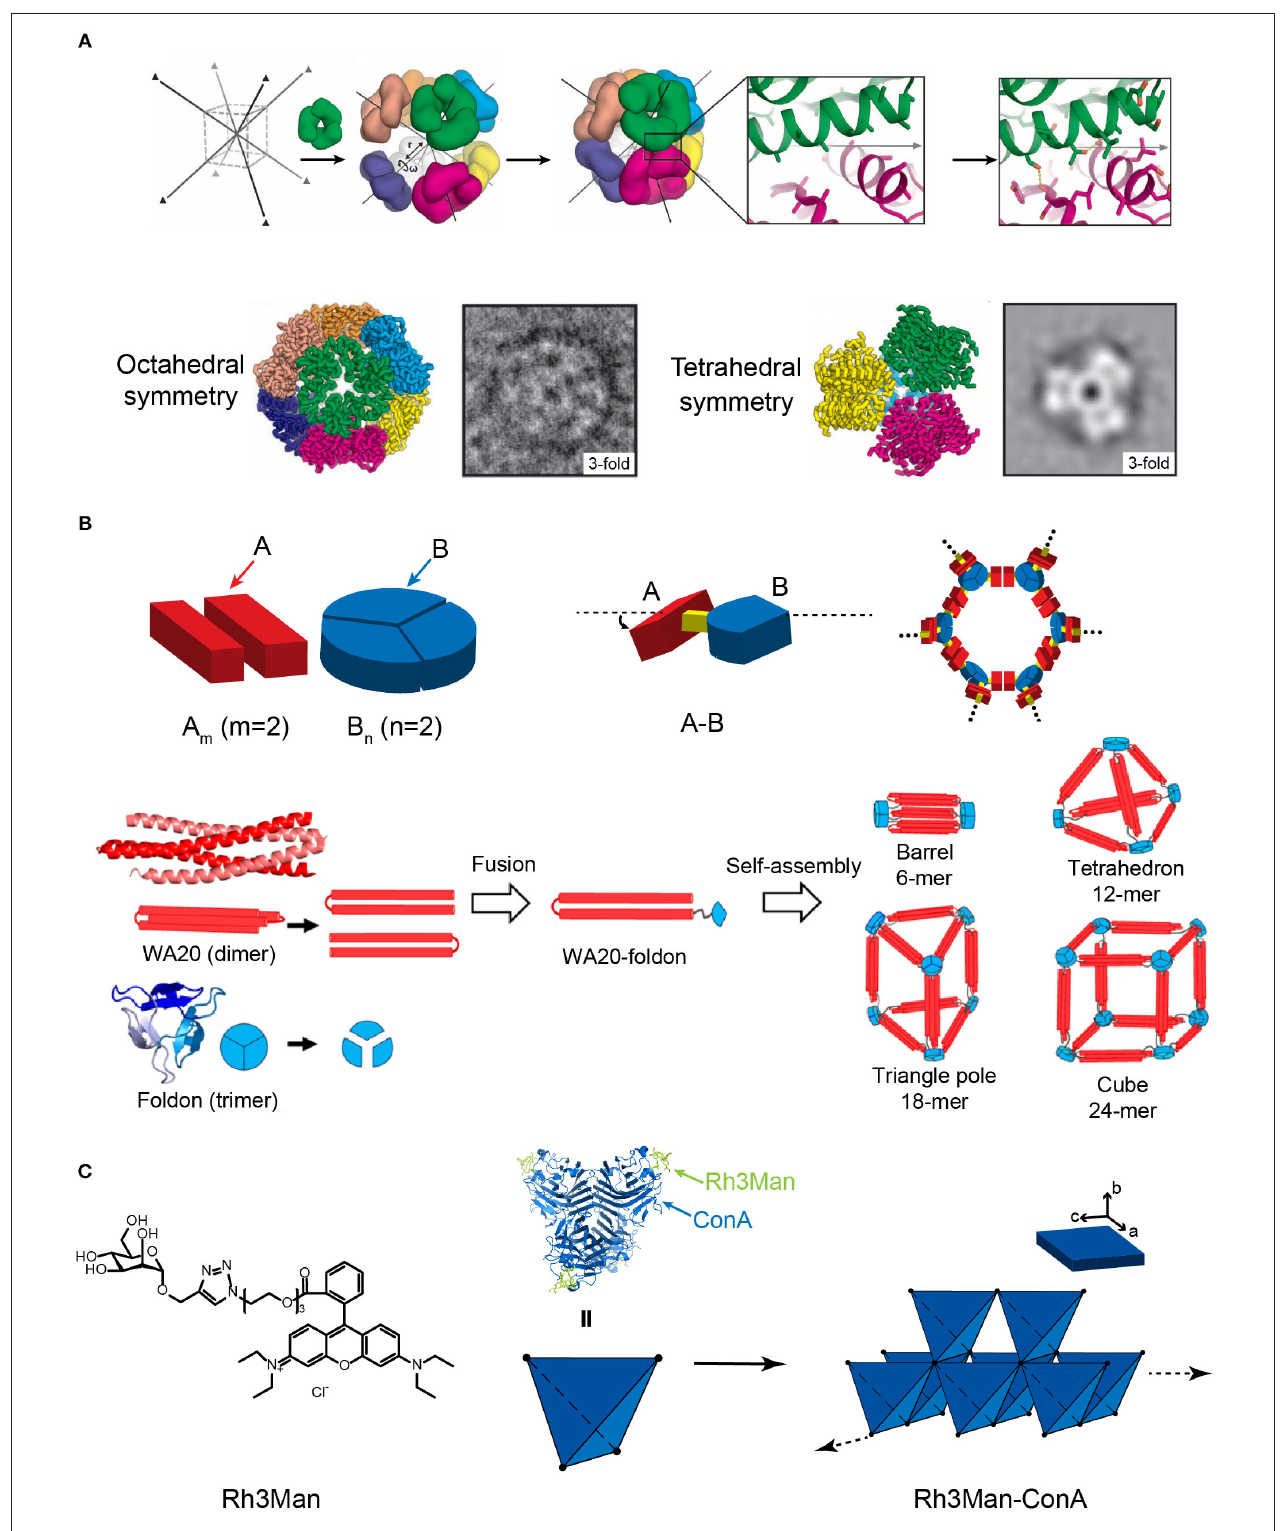
FIGURE 6 | Self-assembled 3D protein superstructures generated by different strategies. (A) Cagelike protein assemblies with octahedral and tetrahedral point group symmetries generated by the computational strategy. Adapted with permission from King et al. (2012). Copyright 2012 The American Association for the Advancement of Science. (B) 3D architectures generated by the symmetry-matching fusion protein assembly strategy. The general strategy for designing fusion proteins that